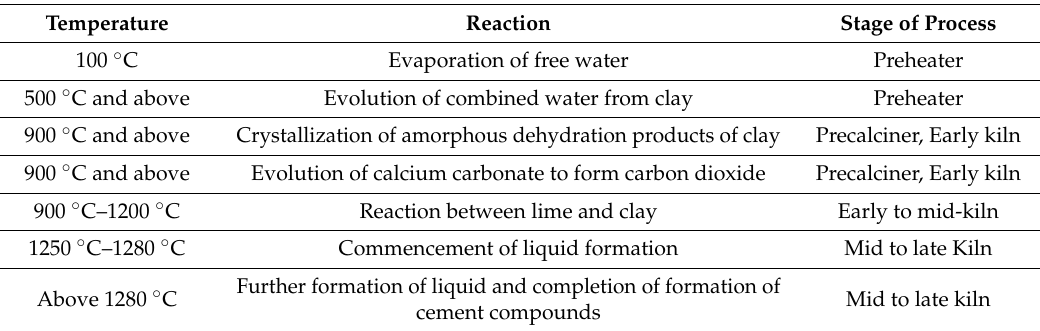
Table 2. Description of reactions occur in various stages